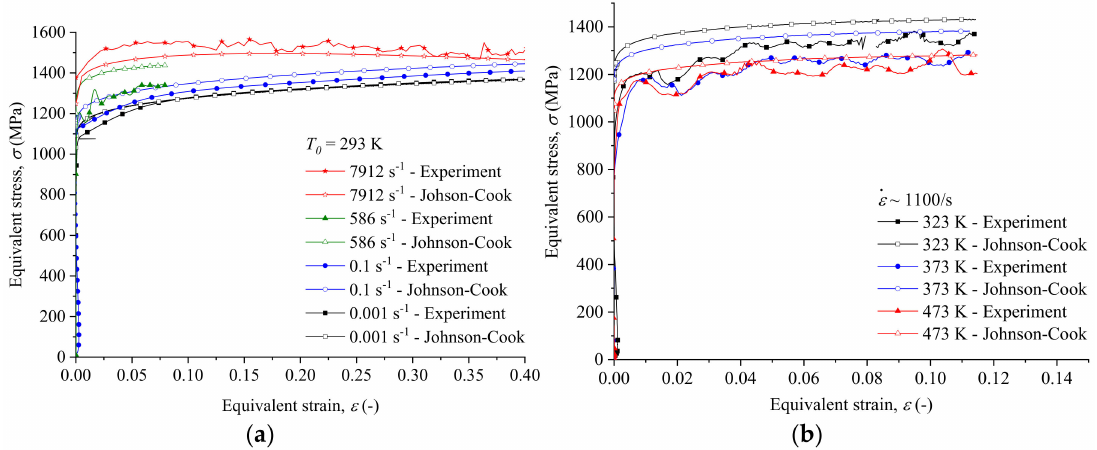
Figure 12. Comparison of the Johnson–Cook model and the experimental data: ( a ) for different strain rates, at T 0 =293 K, ( b ) for different temperatures, at ˙ ε ~1100 s − 1